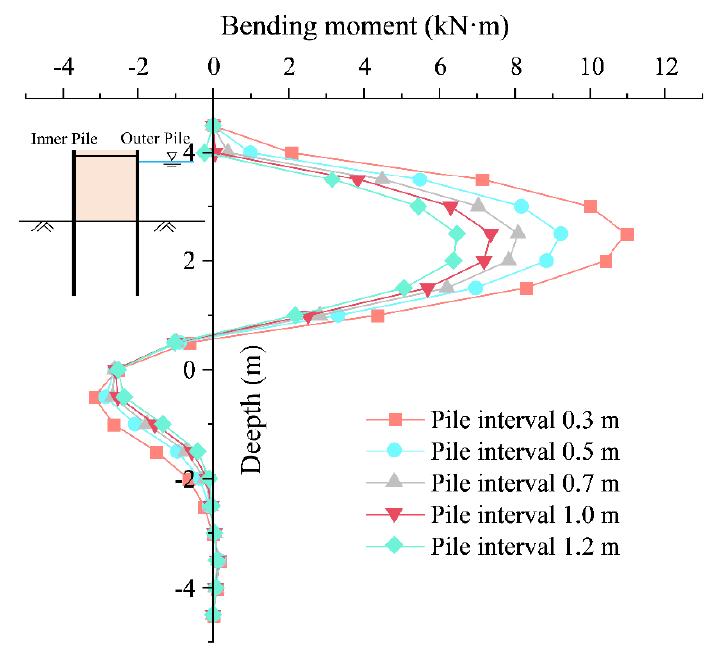
Figure 22. Pile bending moment of wood pile interval conditions.